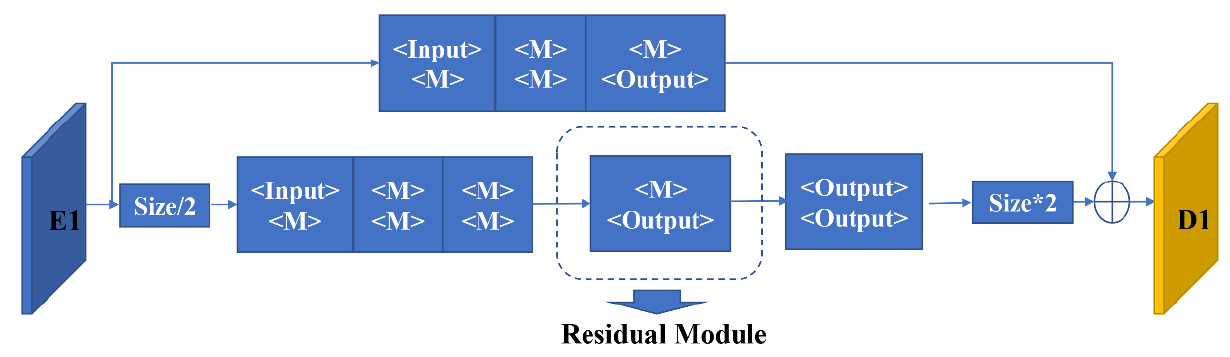
Figure 4. A single layer of the residual module in the Feature Extraction Module.